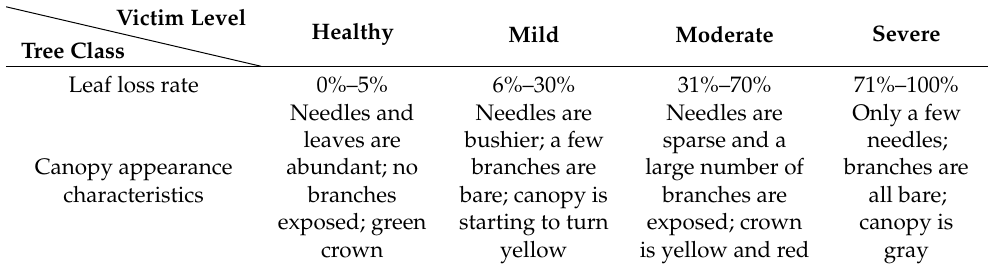
Table 2. In the end, a total of 840 trees were selected as sample trees, 210 trees for each damage class. Table 2. Sample tree damage rating table. Table 2. Sample tree damage rating table.